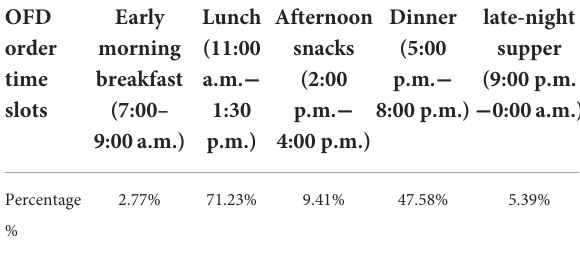
TABLE 2 Distribution of OFD order time intervals from